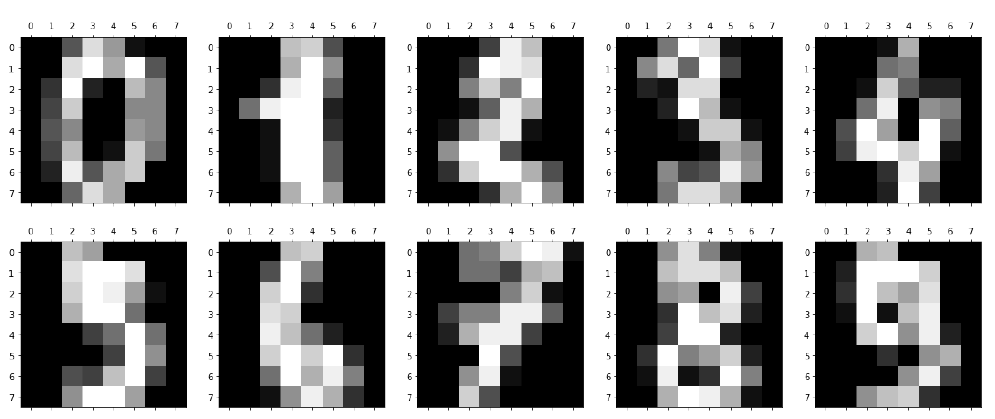
Figure 2. Dataset images sample.